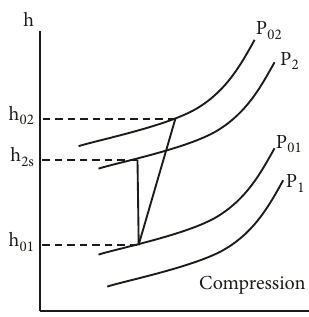
Figure 3: Ideal and realistic expansion process inside gas